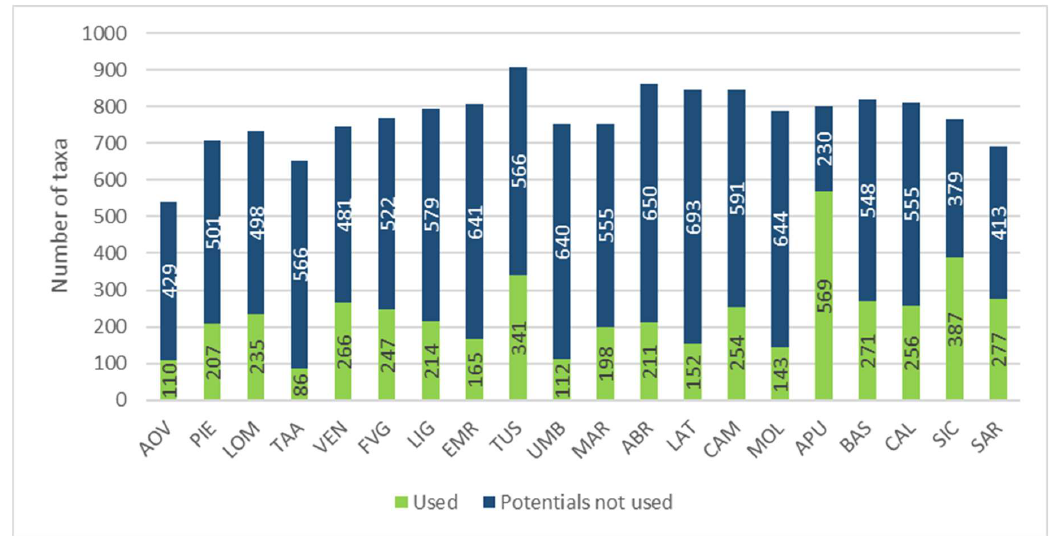
Figure 8. Regional comparison based on the number of recorded and potential alimurgic taxa. Abbreviations of the ad- ministrative regions are shown in Figure 1.